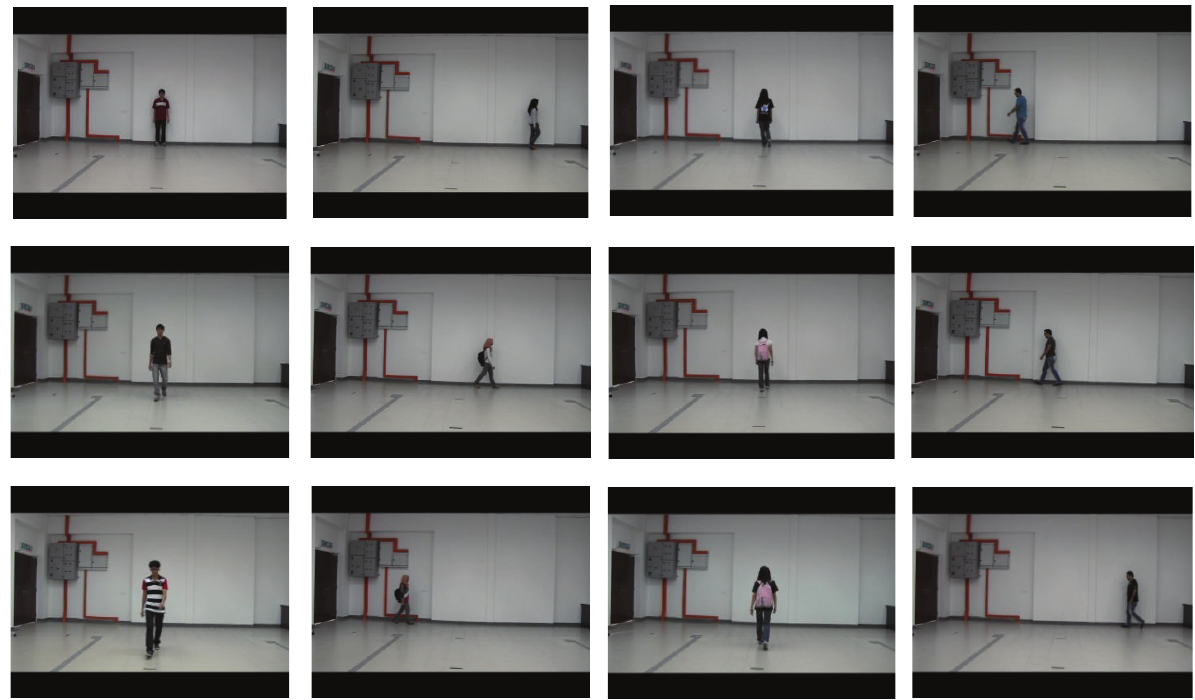
Figure 1: Sample images of four subjects appearing at three different times, covering four different directions, with variation in